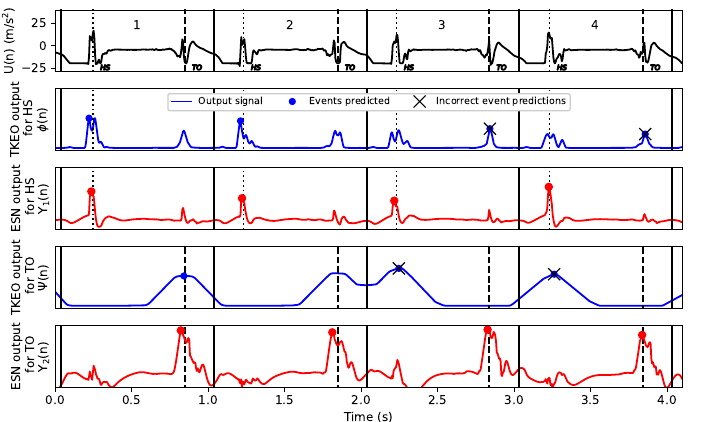
Figure A4. Examples of predictions on a timeseries for the UDS database for the ESN and the TKEO. Four gait cycles are represented. U ( n ) is the AP acceleration. The other subplots show the output signals computed from the TKEO (blue lines), φ ( n ) and χ ( n ), or the ESN (red lines), Y 1 ( n ) and Y 2 ( n ). The events predicted (dots) were identified from the peak finder algorithm applied on each output signal. All the events were correctly predicted by the ESN. For the TKEO, the HS of cycles 1–2 were correctly predicted. HS and TO events of cycles 3–4 were misdetected ( × ), and the TO of cycle 2 was not